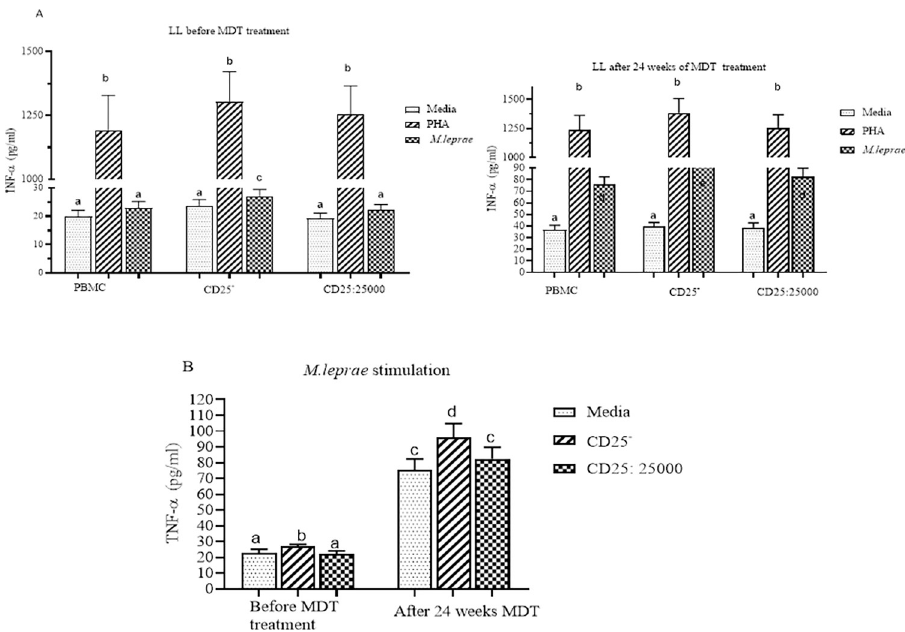
Fig 1. The effect of depletion of CD25 + cells on TNF α secretion by PBMC from LL participants (n = 30). (n = 30): (Fig 1A) TNF α response to PHA and M . leprae WCS stimulation before and after 24 weeks of MDT: (Fig 1B) TNF α response to M . leprae WCS stimulation in control PBMC, CD25 + depleted PBMC and with re-addition of CD25 + cells to CD25 + depleted PBMC from individuals with LL before and after 24 weeks of MDT. Each bar graph shows mean ± 95% CI. Any pair of different letters shows that the mean of TNF α production of the two groups are statistically significantly different at p = 0.05 and any pair of similar letters indicates that the mean of TNF α production the two groups are not statistically significantly different at P � 0.05 and 95% confidence interval (CI). CI is calculated for mean difference. Media indicate AIM-V medium only and it was used in the assay as negative control and PHA used as a mitogen (positive